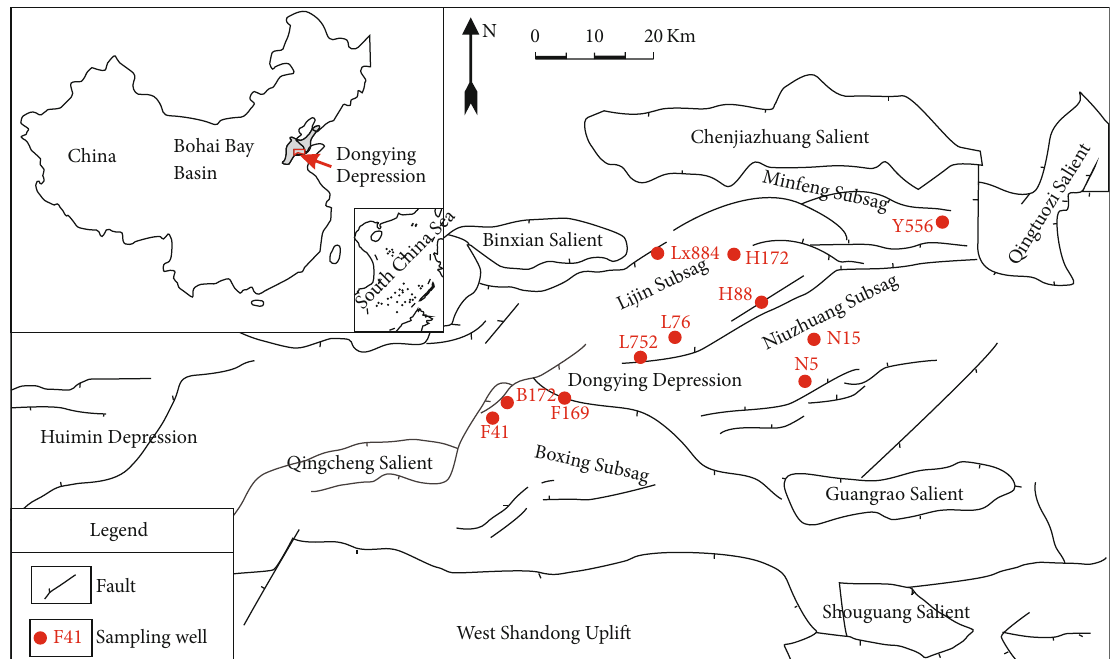
Figure 1: Study area geological structure and sampling locations [6,